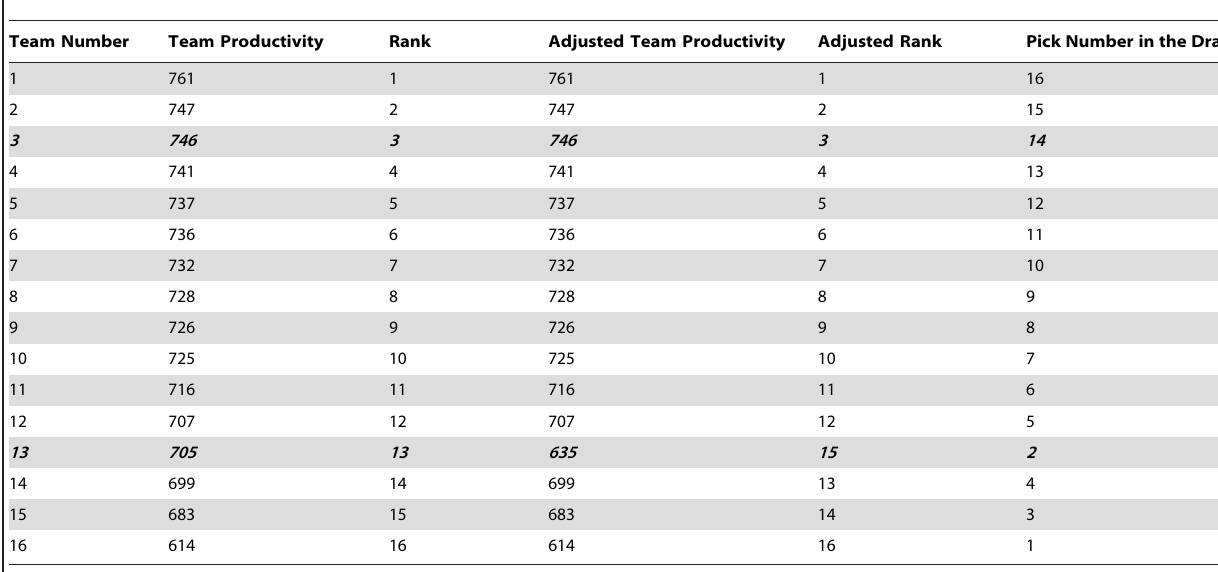
Table 1. An example of the re-ranking process where Teams 3 and 13 (bold italics) have adopted a tanking strategy for a particular